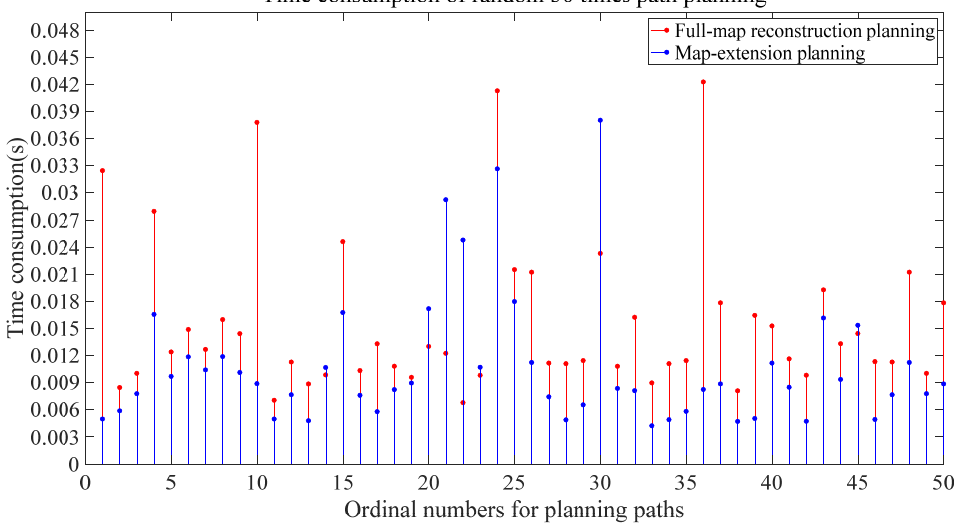
Figure 27. Comparison of time consumption in path planning within the third ‐ updated map.